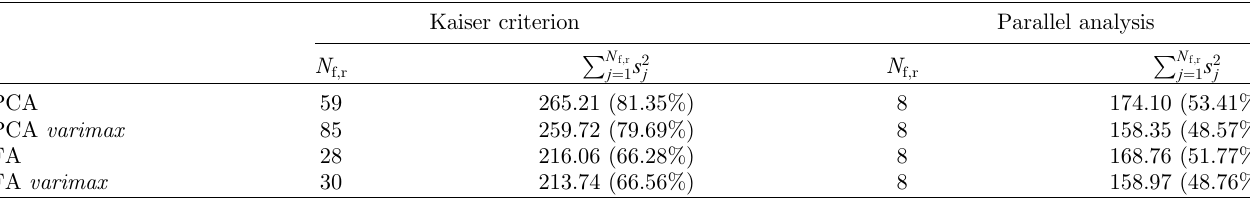
Figure 2. Explained variance ratio in % for PCA and FA both with and wihtout varimax rotation. Table 3. Number N f,r of relevant factors (FA) or principle components (PCA) according to Kaiser criterion and parallel analysis.